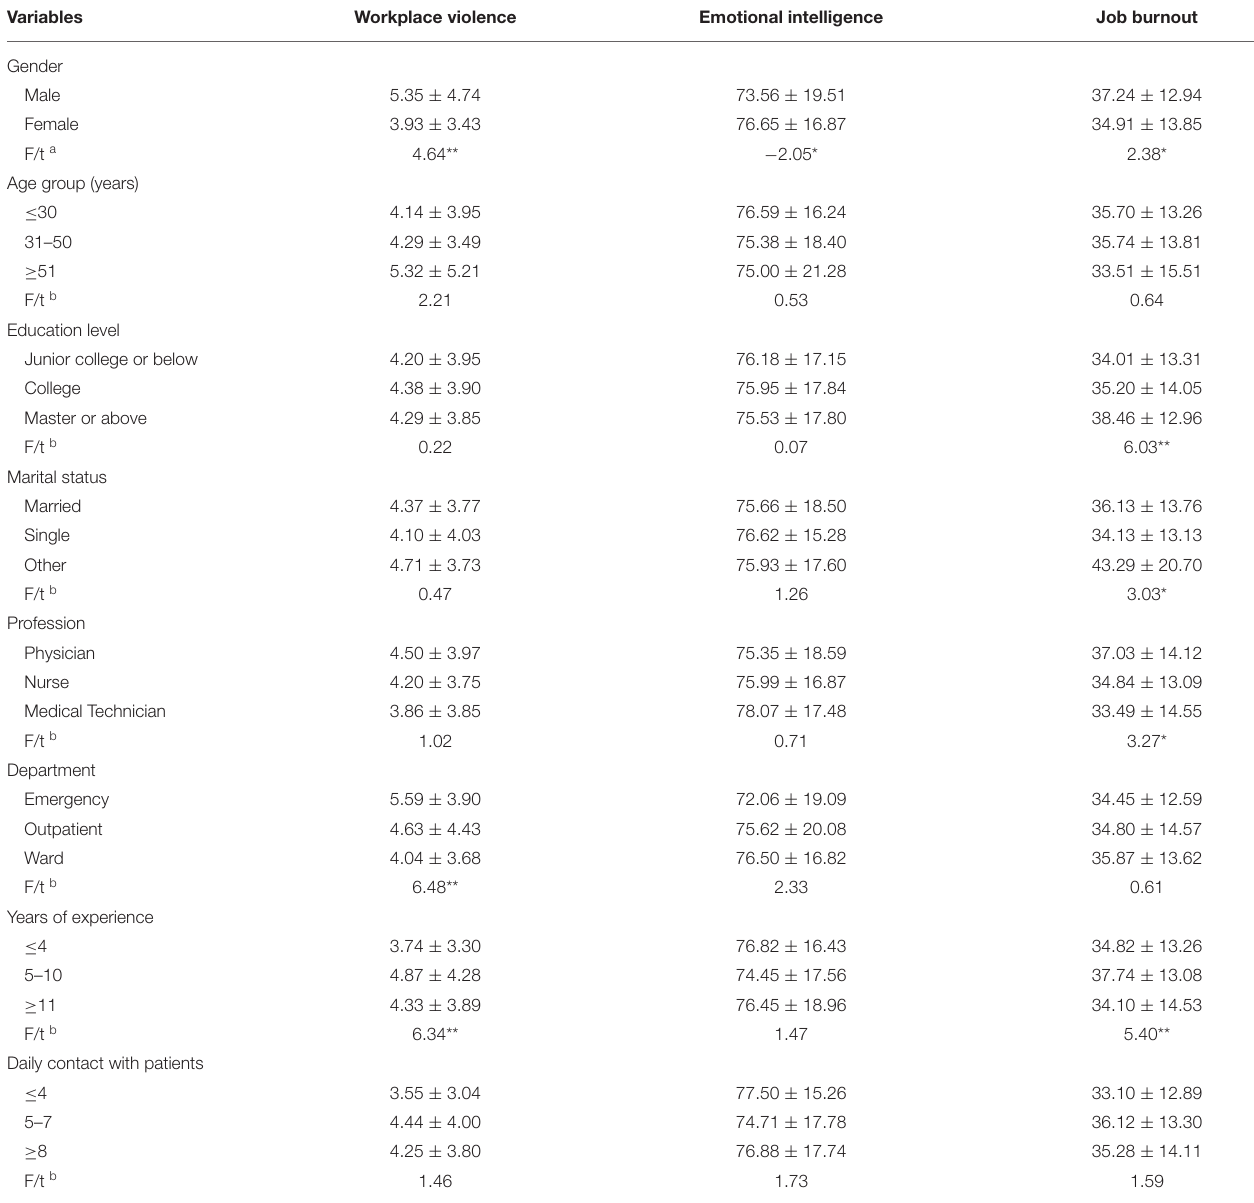
TABLE 2 | Univariate analysis and description of each scale. Variables Workplace violence Emotional